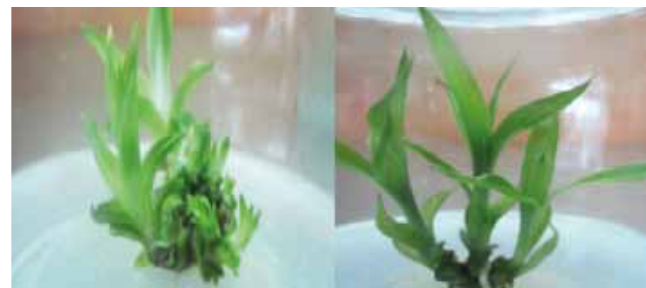
1 - Rate of shoot proliferation in Dracaena ‘Green’ cultured horizon- days after culture (left) and 60 days after culture